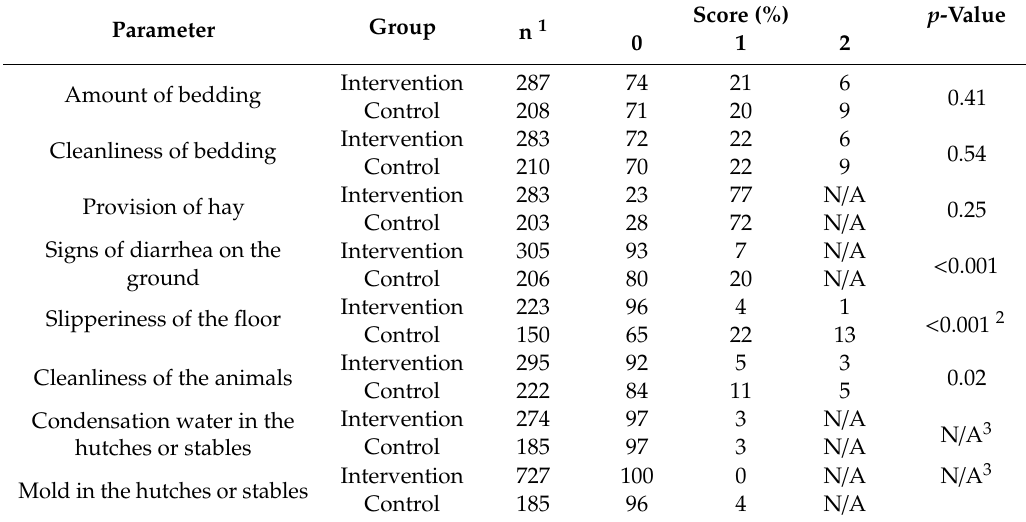
Table 5. Comparison of calf welfare indicators at the group level in intervention and control farms evaluated during monthly visits (306 and 229 farm visits, respectively) using Chi-Square